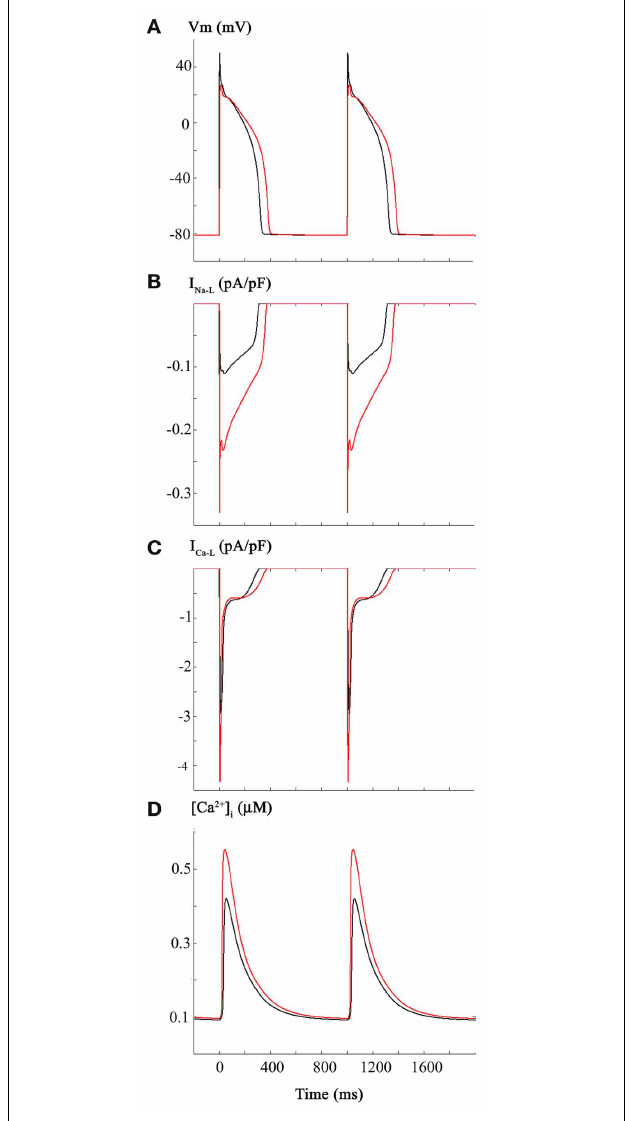
FIGURE 1 | Effects of carbon monoxide (CO) induced changes in Na + current on the action potential in a human ventricular myocyte. In this and all subsequent Figures, the Grandi et al. mathematical model of the human ventricular action potential was employed (see Methods). Control simulations are shown as black traces and simulations generated by selected changes in model parameters are shown in red. Panel (A) consists of control action potentials (black, 1Hz., steady state) together with superimposed action potentials (red) that were elicited by the same stimulus parameters after: (i) reducing peak Na + current by 50%, (ii) shifting the steady state inactivation relationship 5mV in the hyperpolarizing direction, and (iii) altering the mathematical descriptors that govern the slowly inactivating or late sodium current, I Na - L , such that its size was increased 2-fold. As expected, these changes reduced excitability and decreased the dV/dt of the action potential upstroke as well as lengthening the AP at both APD-30 and APD-90. I Na - L records are shown in Panel (B) . In Panels (C,D) the corresponding L-type Ca 2 + current, I Ca - L , and intracellular calcium transient, [Ca 2 + ] i are illustrated. Note that these changes are indirect, i.e., they result from the changes in APD waveform and the intrinsic biophysical properties of I Ca - L and the Ca 2 + -induced Ca 2 + release (CICR)